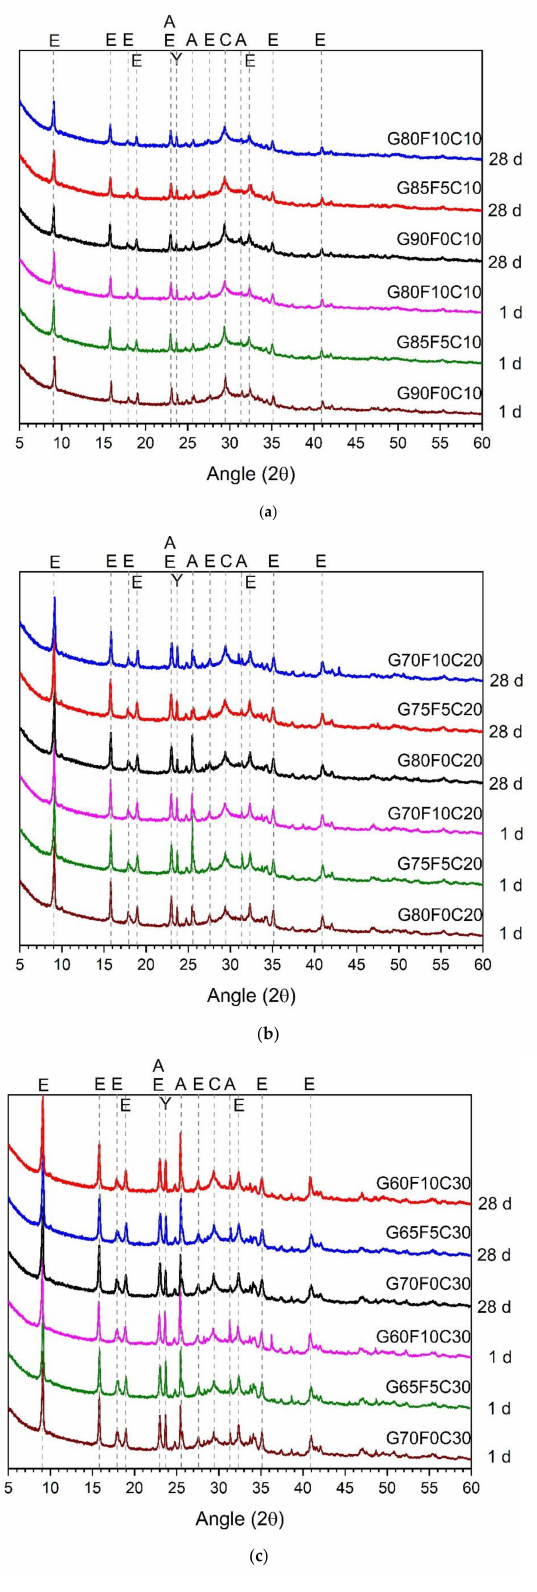
Figure 3. XRD results ( a ) 10% CSAe at 1 d and 28 d ( b ) 20% CSAe at 1 d and 28 d, ( c ) 30% CSAe at 1 d and 28 d, E: ettringite, A: anhydrite, Y: ye’elimite, C: C-S-H/calcite